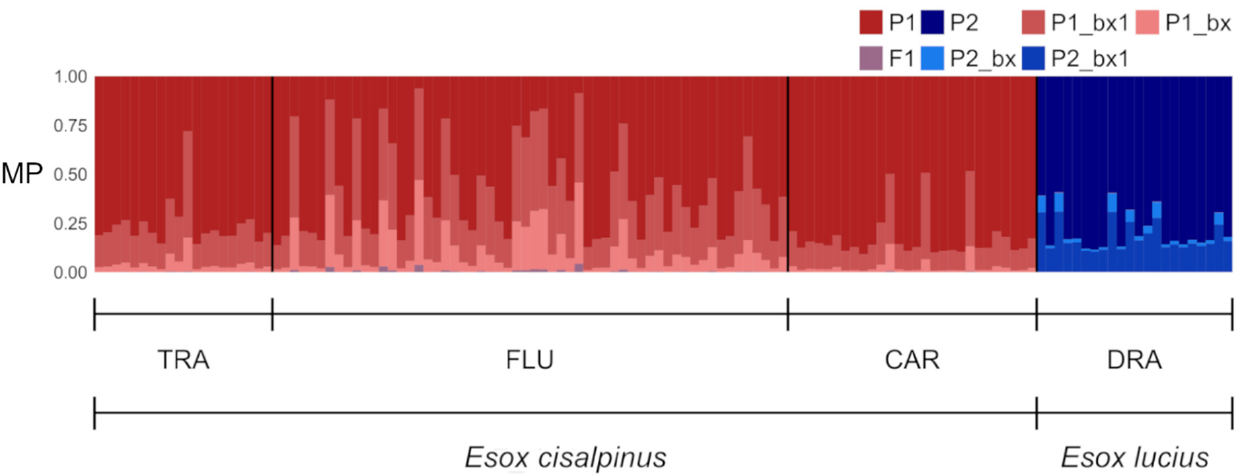
Figure 5. Assignment of individuals to different genotypic classes based on the Expectation–Maximisation algorithm. The bar plot shows the membership probability (MP) of each individual of being a pure southern or northern pike, an F1, or a backcross hybrid between the two parental species. Genotypic classes are arranged as in Figure 4; note, however, that the algorithm implemented in SNAPCLUST does not allow one to distinguish F2 hybrids.